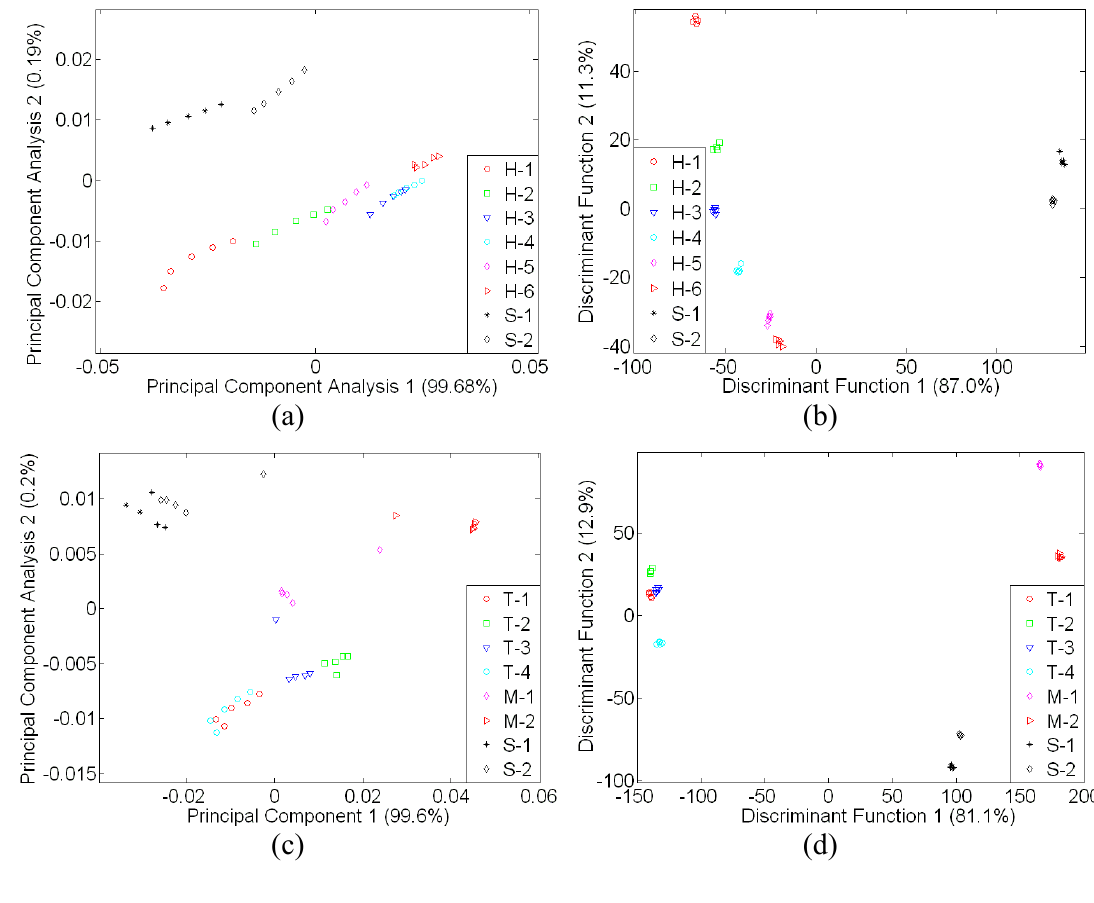
Figure 5. Separate plot of 32 e-nose sensor results for honey assessment: ( a ) PCA plot of Leaf, Durian, Malaluka, Coconut, Starfruit, Wax Apple Honey, Nona and Bunga Raya, ( b ) LDA plot of Leaf, Durian, Malaluka, Coconut, Starfruit, Wax Apple Honey, Nona and Bunga Raya, ( c ) PCA plot of four different brands of Tualang Honey, Nona, Bunga Raya and two adulterated samples, ( d ) LDA plot of four different brands of Tualang Honey, Nona, Bunga Raya and two adulterated samples, ( e ) PCA plot of four different floral origin of New Zealand honey, Nona and Bunga Raya, and ( f ) LDA plot of New Zealand honey of four different floral origins, Nona and Bunga